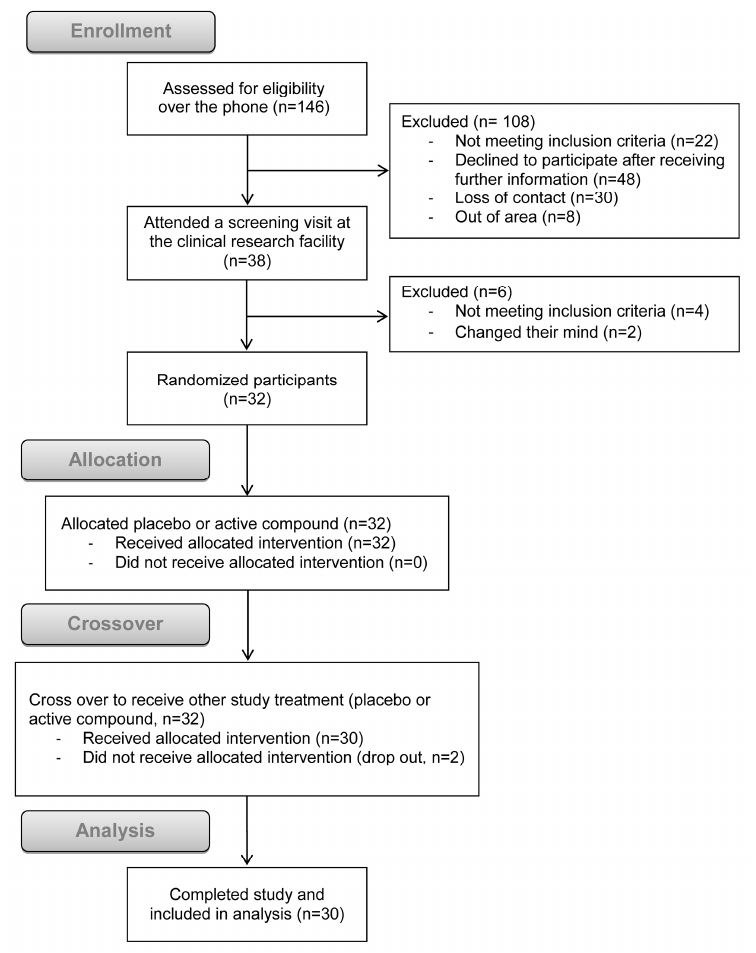
Figure 1. Consolidated Standards of Reporting Trials (CONSORT) flow diagram of the study (adapted from Schulz et al. [17]).